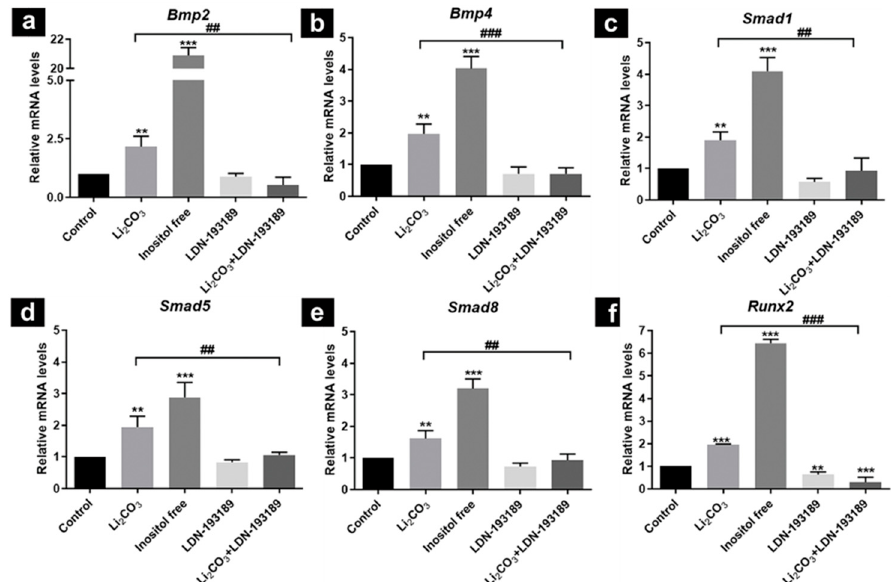
Figure 3. Gene expressions of BMP signaling molecules in mNSCs. Cultured mNSCs were exposed to Li 2 CO 3 (1.5 mM), or inositol-free medium, treated with or without LDN-193189 (1 μ M). Gene expressions of ( a ) Bmp2 , ( b ) Bmp4 , ( c ) Smad1 , ( d ) Smad5 , ( e ) Smad8, and ( f ) Runx2 were determined. Data are shown as mean ± SD (n = 5); ** p < 0.01 and *** p < 0.001 vs. control group; ## p < 0.01 and ### p < 0.001 comparing the Li 2 CO 3 and Li 2 CO 3 + LDN-193189 groups.